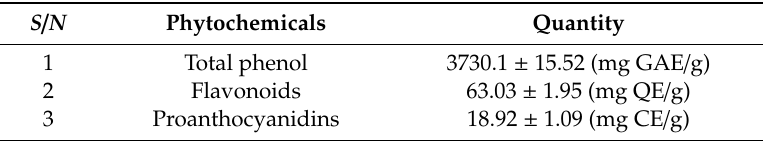
Table 1. Quantitative analysis of phytochemicals in aqueous extracts. GAE, gallic acid equivalent, QU, quercetin equivalent, CE, catechin equivalent.